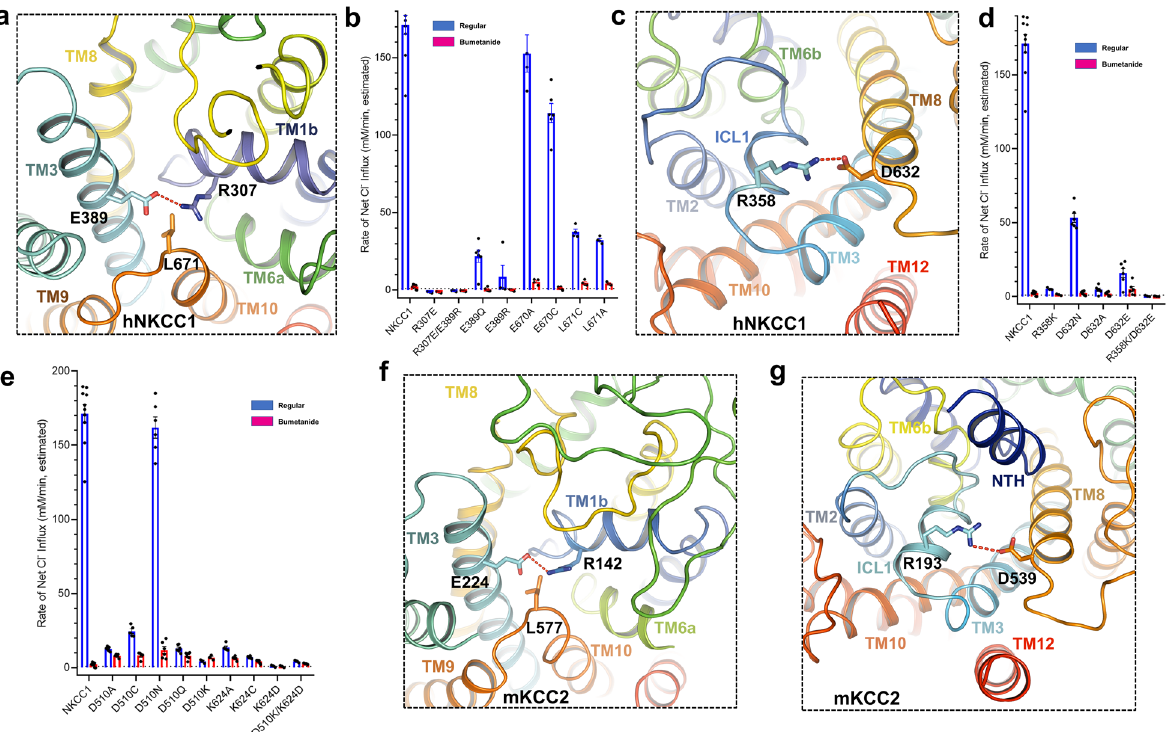
Fig. 3 Potential gating residues in hNKCC1 and mKCC2. a The amino group of R307 of TM1b interacts with the carbonyl oxygen of E389 from TM3 to constrict the extracellular gate of hNKCC1. b hNKCC1 transport activity is greatly decreased by mutation of the extracellular gating amino acids E389, R307, and L671; mean ± SEM. c At the intracellular end of the hNKCC1 translocation pore, R358 of ICL1 interacts with D632 of the neighboring TM8. d hNKCC1 transport activity between WT and mutants in the intracellular essential amino acids (R358 and D632); mean ± SEM. e hNKCC1 mutants of D510 and K624 at the intracellular end of the pore have greatly reduced transport activity — these residues are implicated in MD simulations (see also Supplementary Fig. 10a, b); mean ± SEM. f Homologous to hNKCC1 ( a ), the extracellular gate of mKCC2 is restricted by hydrogen bonds between R142 of TM1b and E224 of TM3. g Potential intracellular-gating residues of mKCC2: homologous to hNKCC1 ( c ), R193 of ICL1 in mKCC2 is close to D539 of